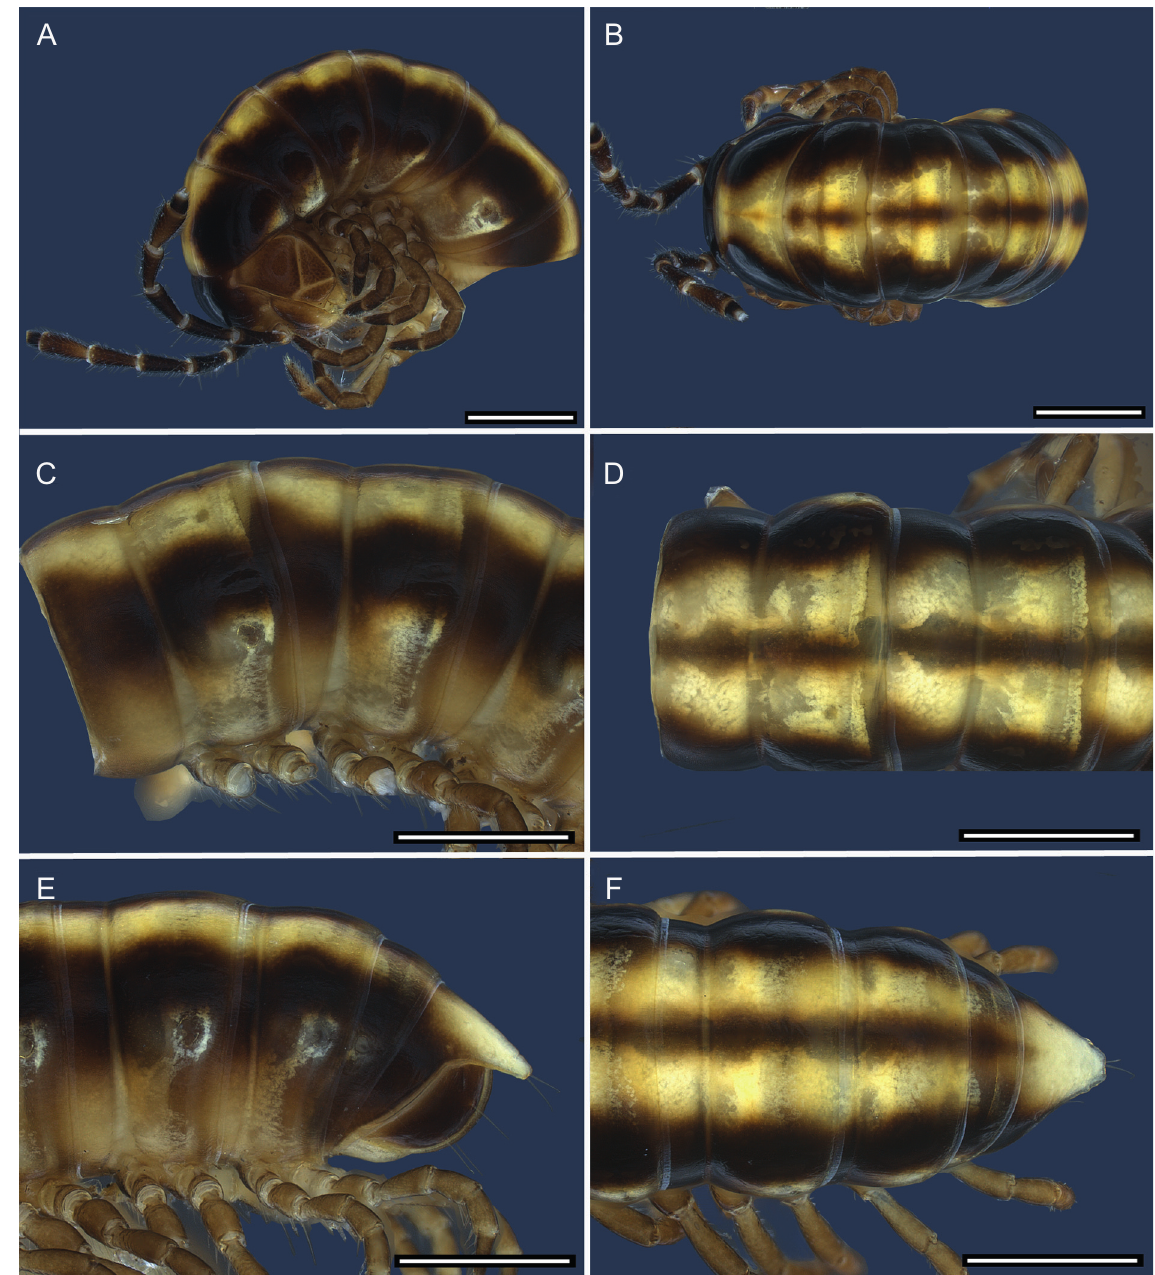
Fig. 8. Pogonosternum nigrovirgatum (Carl, 1902), ♂, from Kennett River, Grey River Road (NMV K-13114). A – B . Anterior rings. A . Left lateral view. B . Dorsal view. C – D . Rings 10 and 11. C . Left lateral view. D . Dorsal view. E – F . Posterior rings. E . Left lateral view. F . Dorsal view. Scale bars: 1